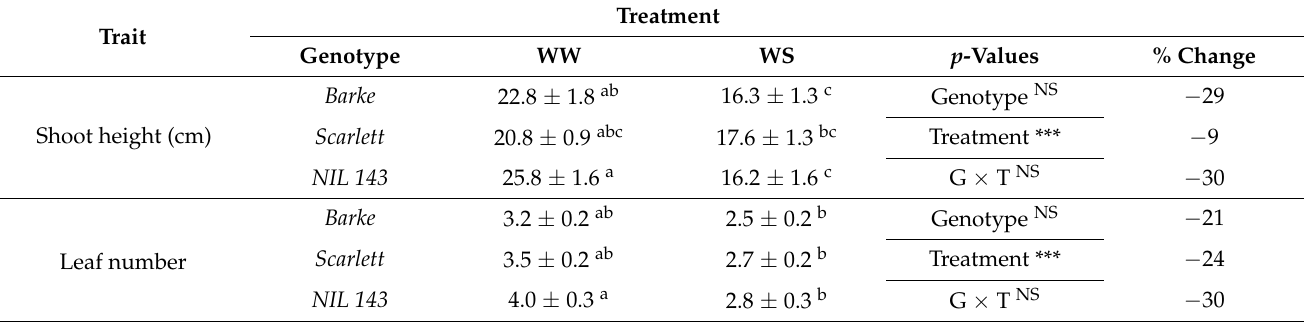
Table 1. Root and shoot traits among the different barley genotypes 17 days after the onset of water stress in the rhizoboxes experiment.